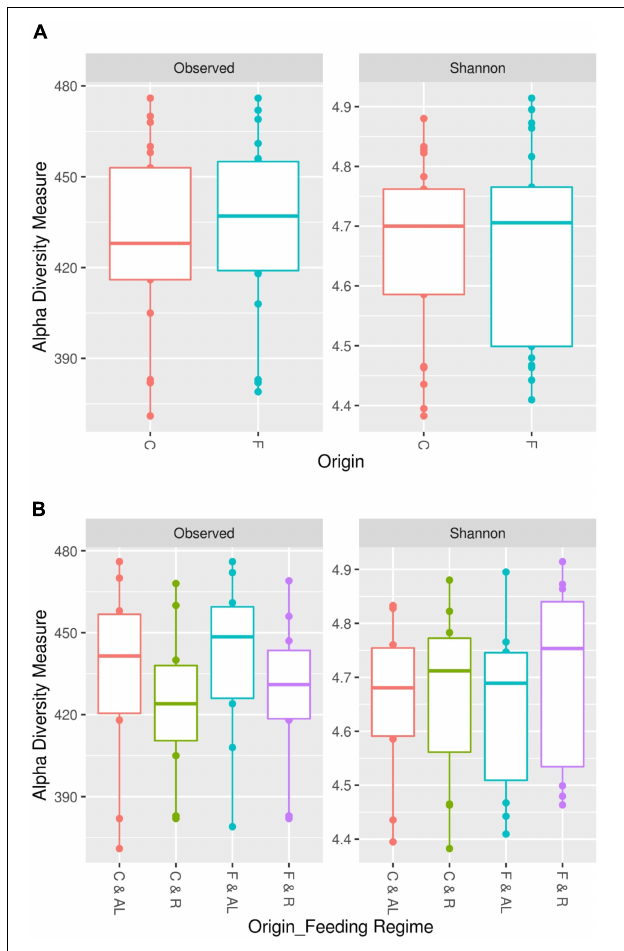
FIGURE 1 | Microbial richness and diversity between cecum and feces samples. The intestinal microbial richness was estimated by the observed number of OTUs index and the microbial diversity was studied by Shannon index. Both indexes were computed at 15,000 contigs. (A) Significant differences in microbial richness and diversity between cecum (C) and feces (F) samples were not identified ( P > 0.05; paired samples analysis of variance). (B) Significant differences in microbial richness and diversity between cecum and feces samples in ad libitum (AL) or restricted (R) rabbits were not identified ( P > 0.05; paired samples analysis of